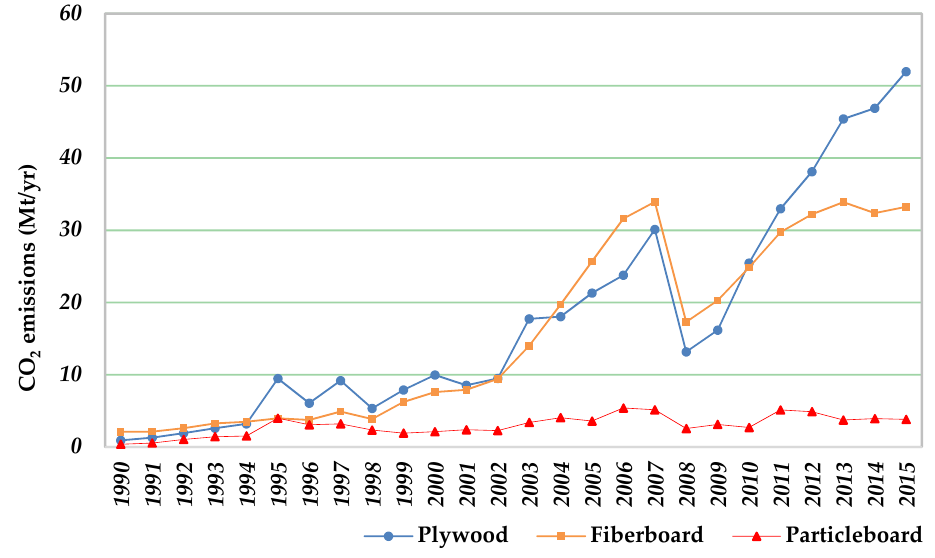
Figure 3. On ‐ site CO 2 emissions for the manufacture of China’s wood ‐ based panels. Figure 3. On-site CO 2 emissions for the manufacture of China’s wood-based